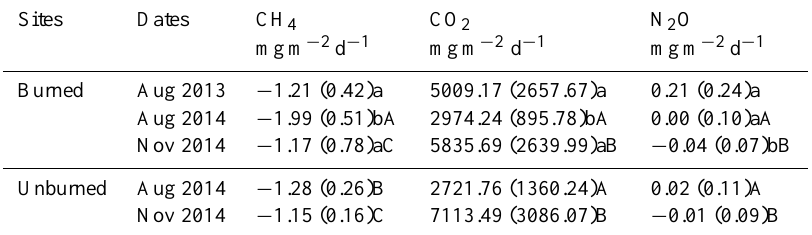
Table 2. Average gas exchange rates from surface soil in Toohey Forest before and after the prescribed burning. Values in parentheses indicate standard errors for the four replicate plots of each sampling period. Significant differences between measurements before and after the burning in the burned plots presented in lowercase letters. Significant differences between burned and adjacent unburned plots presented in uppercase letters. Mean values followed by the same letter are not significantly different (one-way ANOVA, p ≥ 0 . 05).